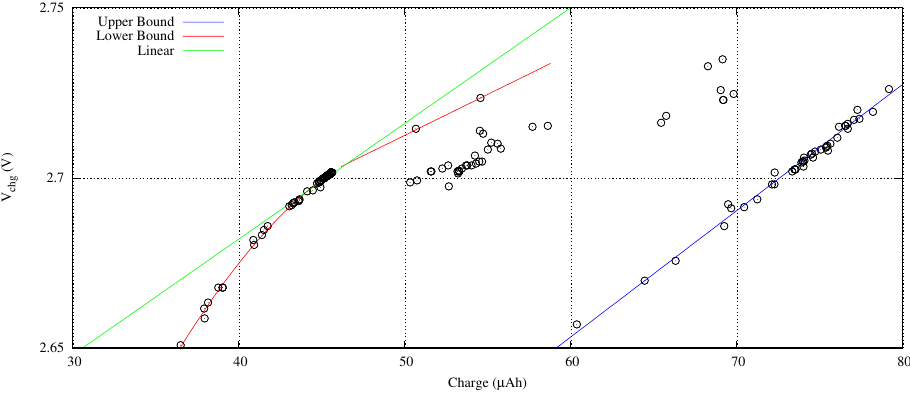
Figure 9. Target voltage against charge Pareto front curve.